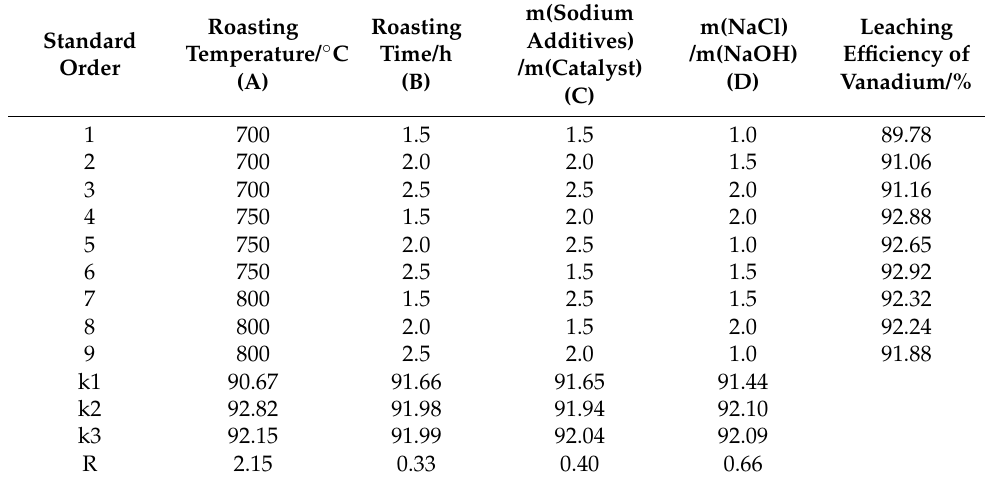
Table 3. Orthogonal experiment design and results of leaching vanadium.